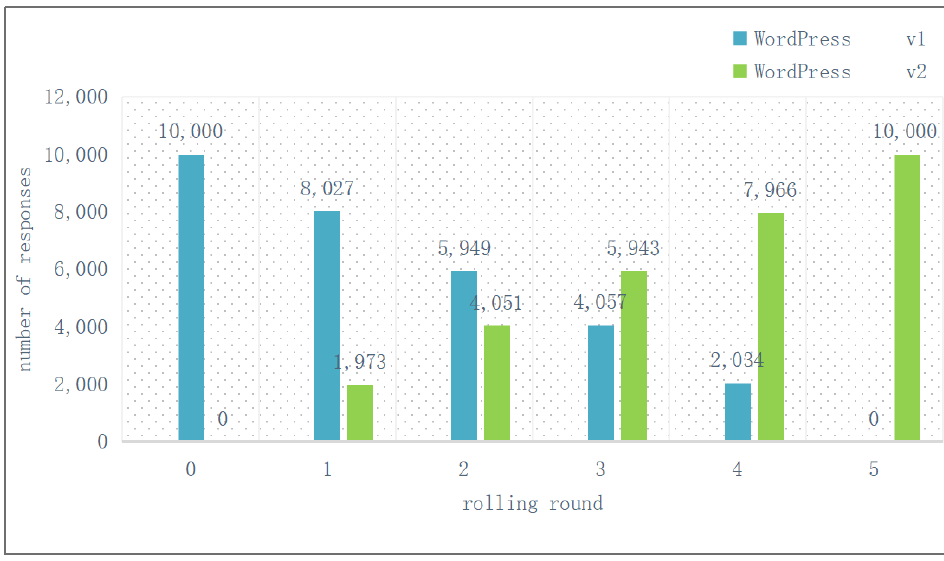
Figure 12. Progress of rolling